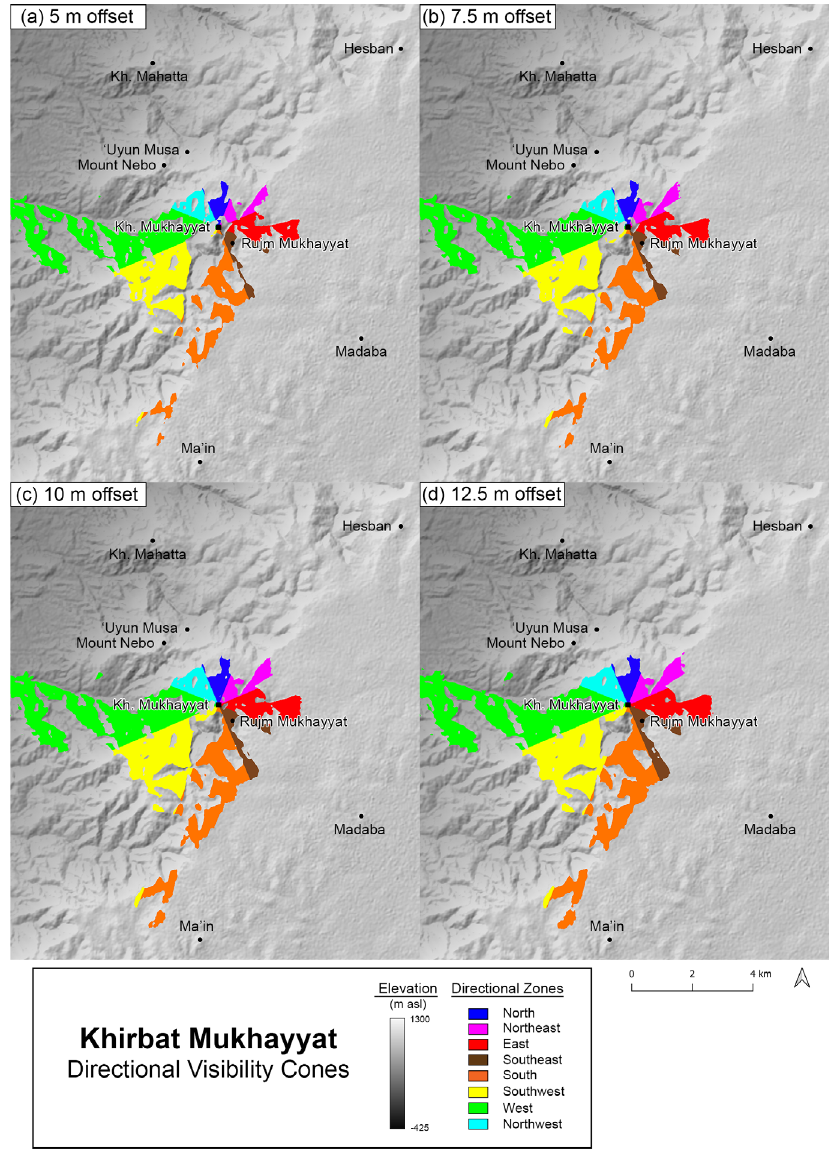
Figure 8: Map showing the directional visibility cones as measured from Khirbat al-Mukhayyat. Panels correspond to the observer/target offsets used in the generation of each viewshed raster map: (a) 5 m; (b) 7.5 m; (c) 10 m; (d) 12.5 m. Panels show only a detail of the central region of the viewshed. For the full extent of the viewshed at the maximum observer/target offset, see Fig.